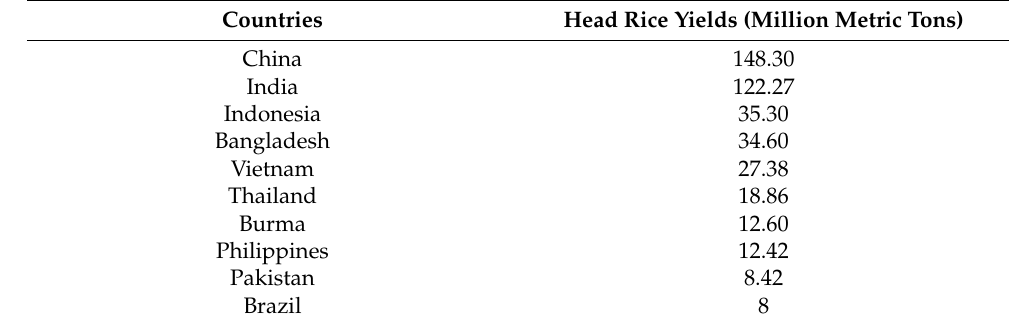
Table 1. Production patterns of head rice yields (million metric tons) across the globe in major rice-producing regions Source: